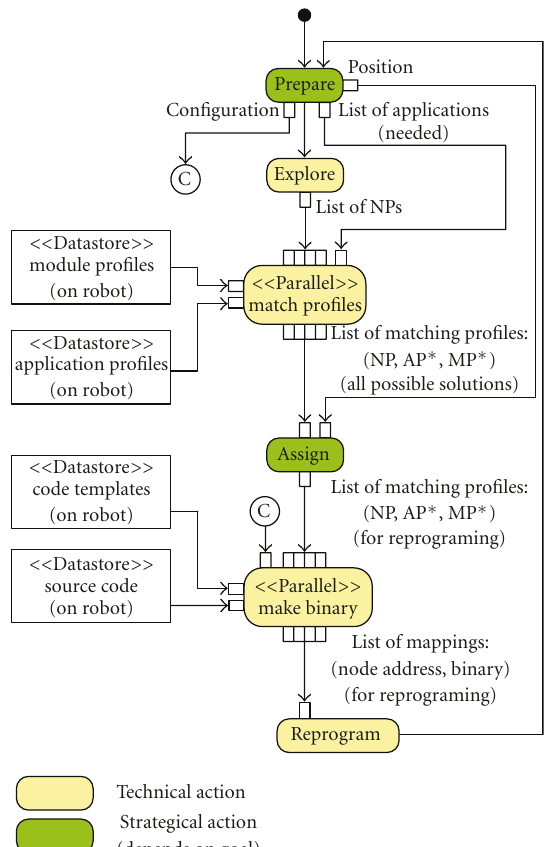
Figure 2: Activity diagram of the reconfiguration